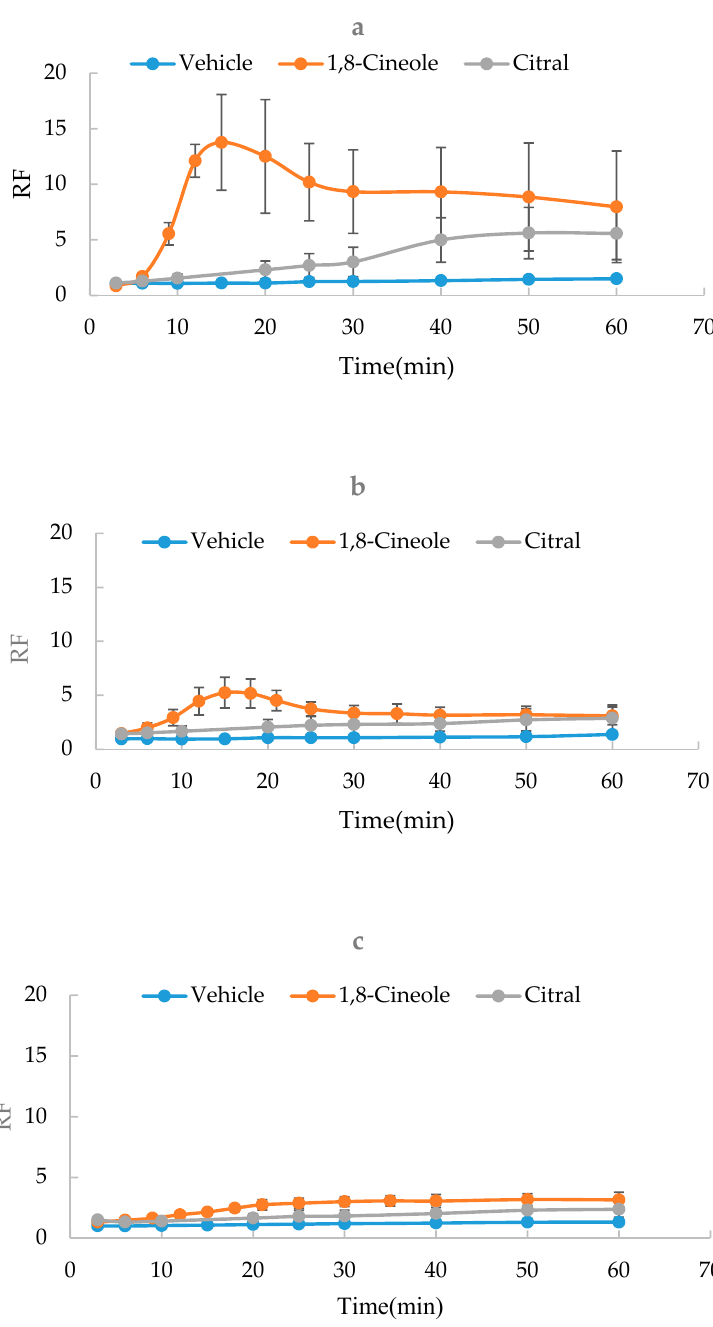
Figure 1. Effect of temperature on skin electrical resistance (SER) kinetics of 1,8-cineole, citral and vehicle ( n = 3). ( a ) 37 °C; ( b ) 32 °C; ( c ) 25 °C.